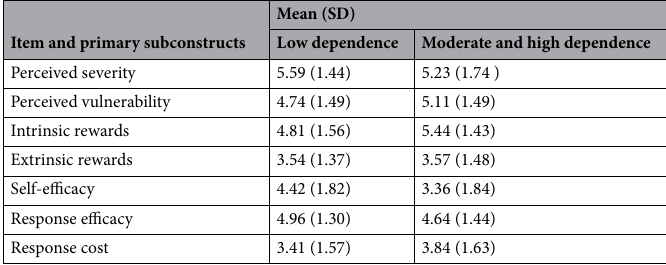
Table 2. Item score of the PMT.